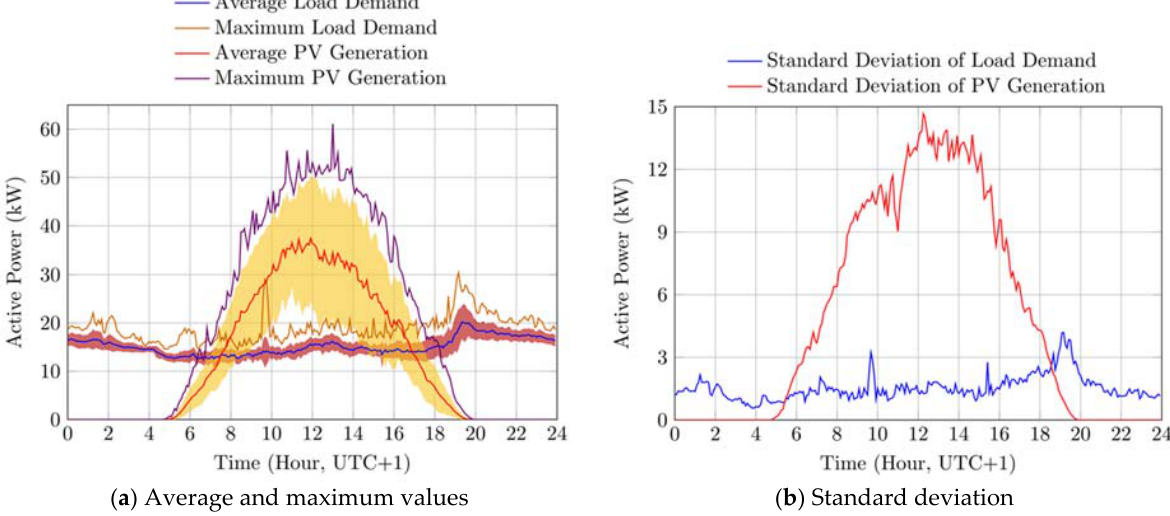
Figure 4. Active power demand profiles of loads and PV active power generation during May 2020. In sub-figure ( a ), the red and yellow areas represent the standard deviation of the measurements for each i -th time interval for the power demand of loads and the PV generation, respectively. The latter are reported in detail in sub-figure ( b ). UTC: universal time